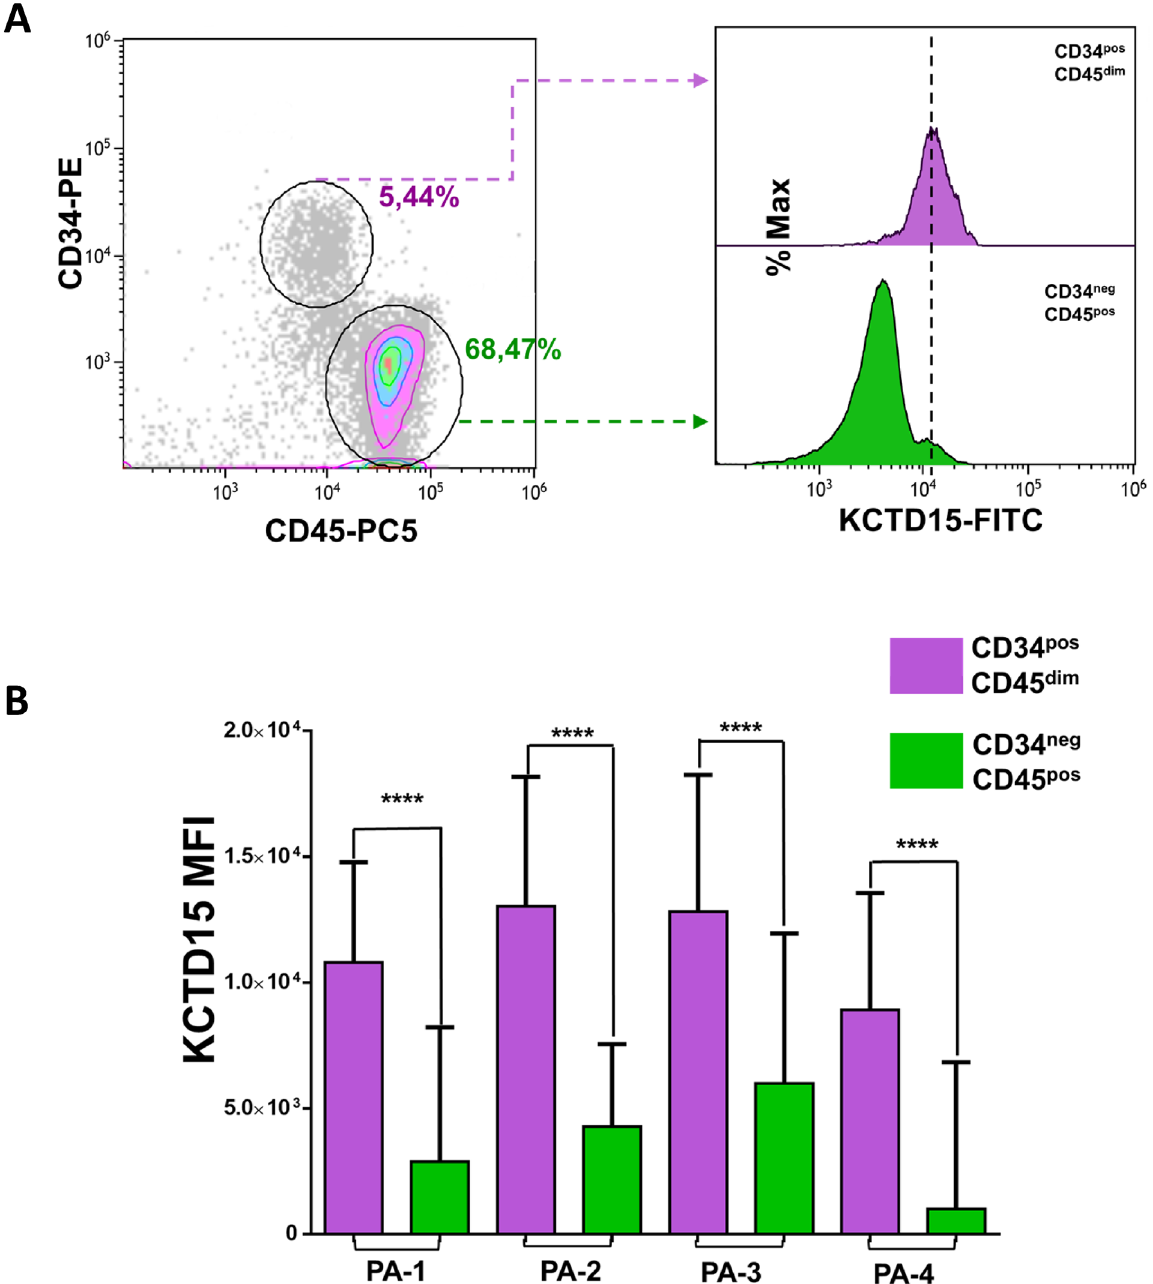
Figure 6. KCTD15 upregulation in hematopoietic stem cells. ( A ) Contour with density plot showing the selection of hematopoietic stem cells (CD34 pos /CD45 dim events) and mature cells (CD34 neg /CD45 pos events) in density gradient purified BM cells from a B-ALL patient after therapy at day + 78. Numbers are referred to as the percentage of gated cells. ( B ) Bar-plot displaying KCTD15 fluorescence intensity (in term of mean of fluorescence and SD) in CD34 pos /CD45 dim (violet) and CD34 neg /CD45 pos (green) (****p < 0.0001, unpaired t test). The error bar represents